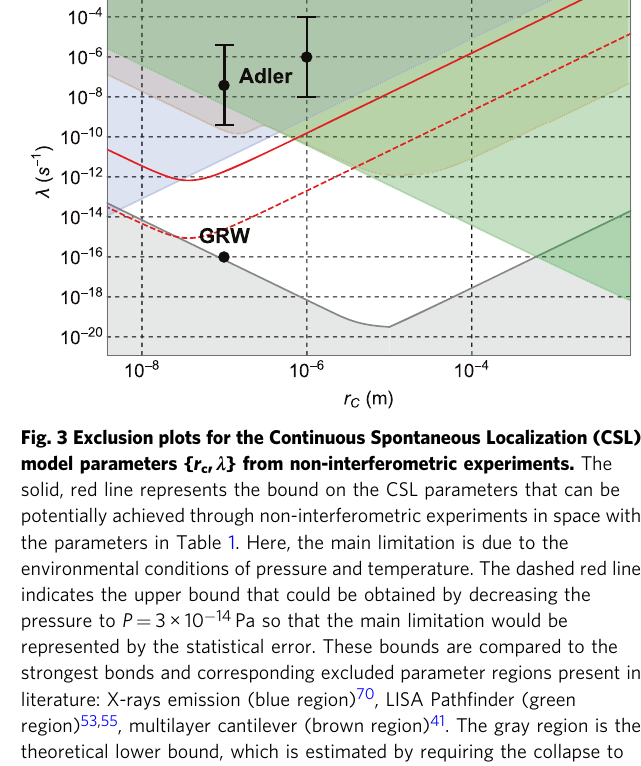
ffiffiffiffiffiffiffiffiffiffiffiffiffiffiffiffiffiffiffiffi